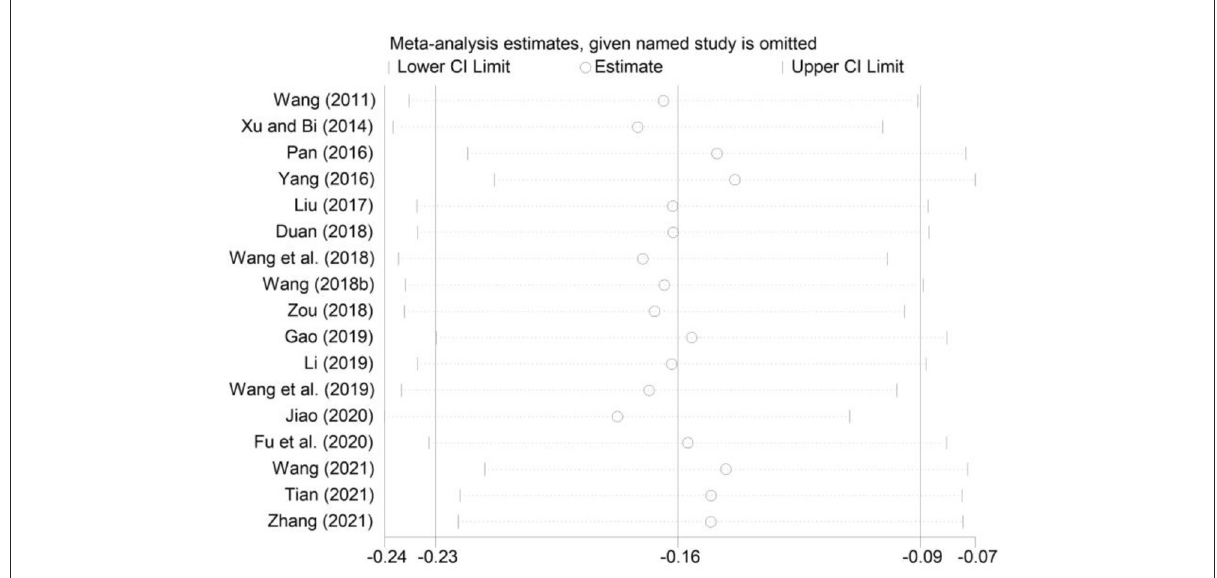
FIGURE7 Sensitivity analysis of the correlation between smartphone addiction and social